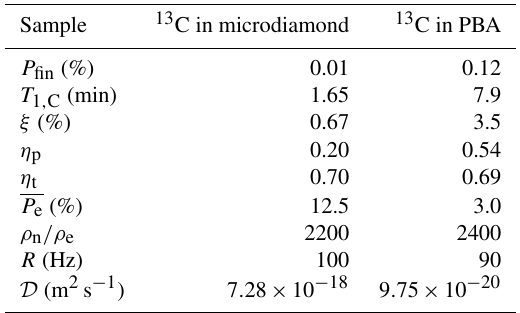
Table 3. Comparison of parameters of the DNP experiment.